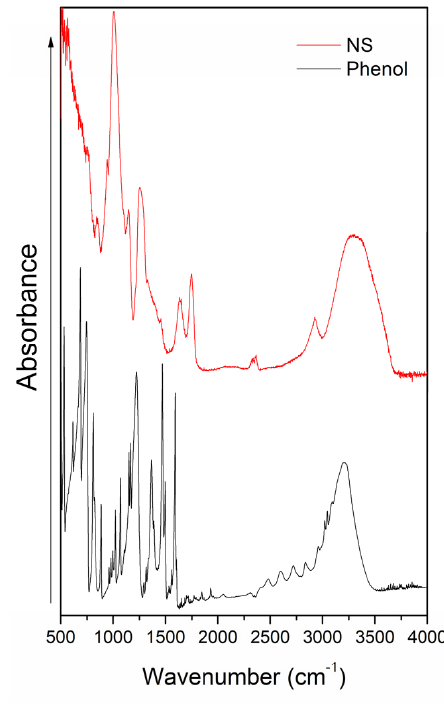
Figure A4. FT-IR spectra of NSs and phenol.